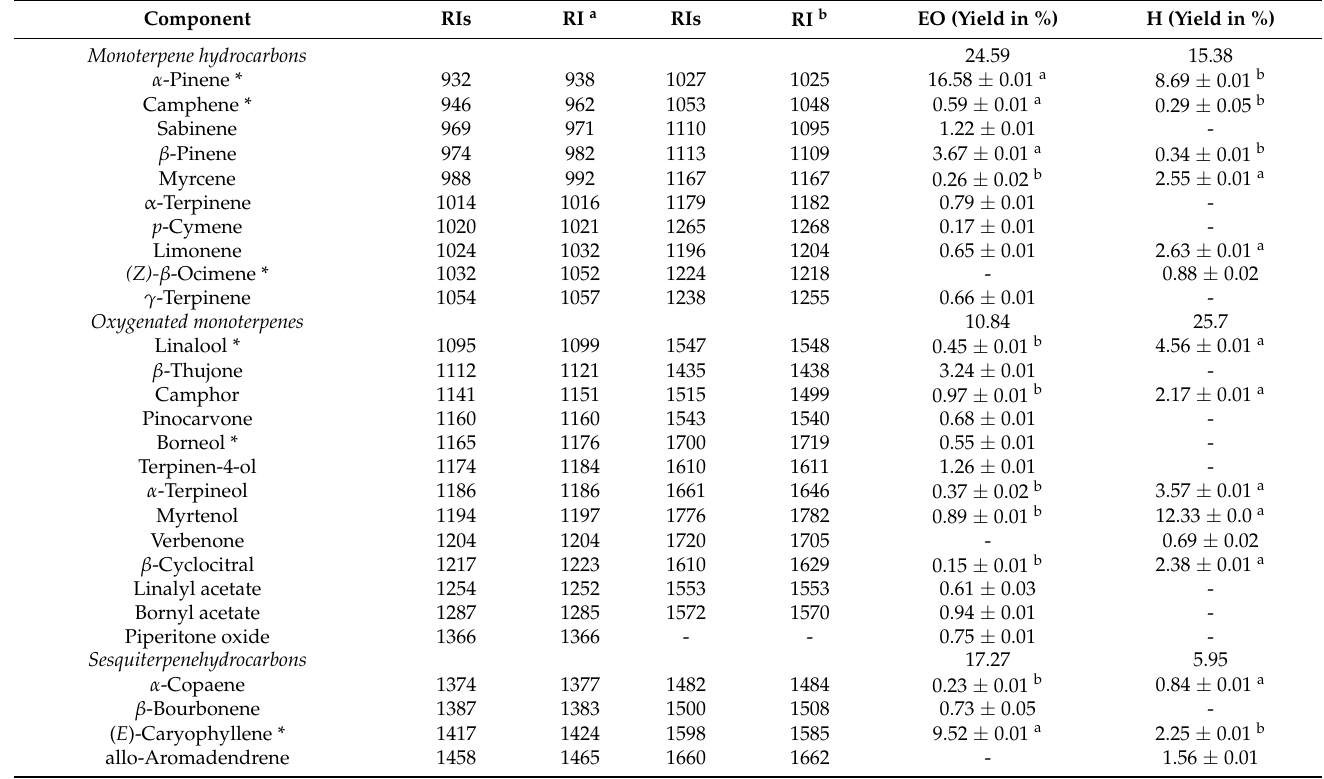
Table 1. Phytochemical composition (% ± SD) of the essential oil (EO) and hydrosol (H) from aerial parts of Hypericum perforatum ssp. veronense